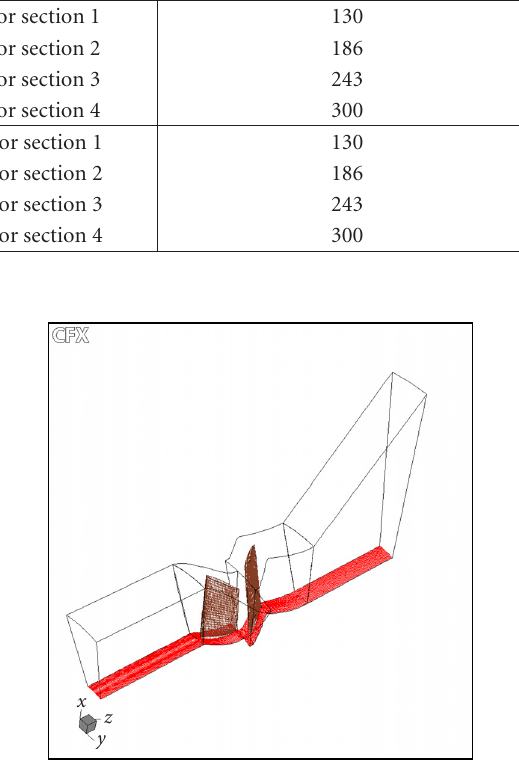
Figure 2: View of the mesh and of the calculation domain.